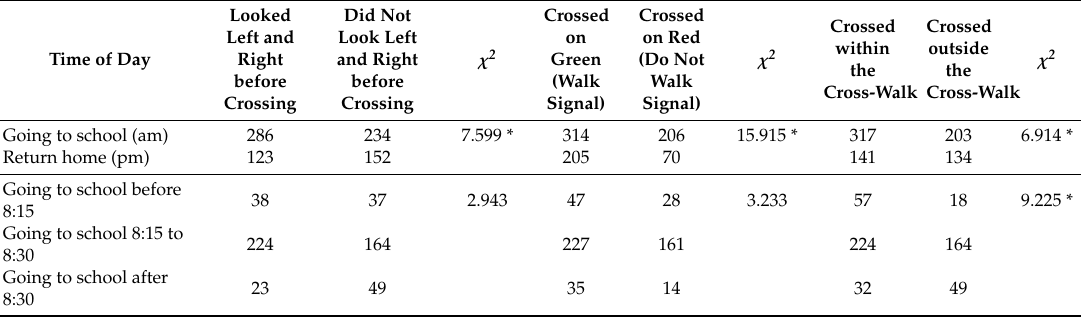
Table 5. Safe behaviour associated with time of day (number of road crossings) * p <